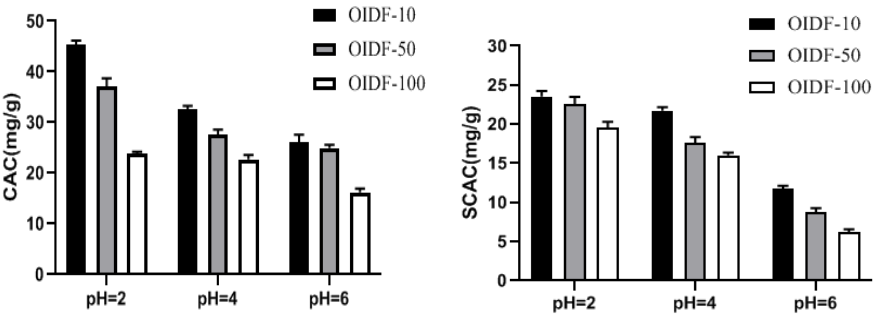
Figure 3. The effect of different particle sizes of OIDF on the adsorption of cholesterol (CAC) and sodium cholate (SCAC).